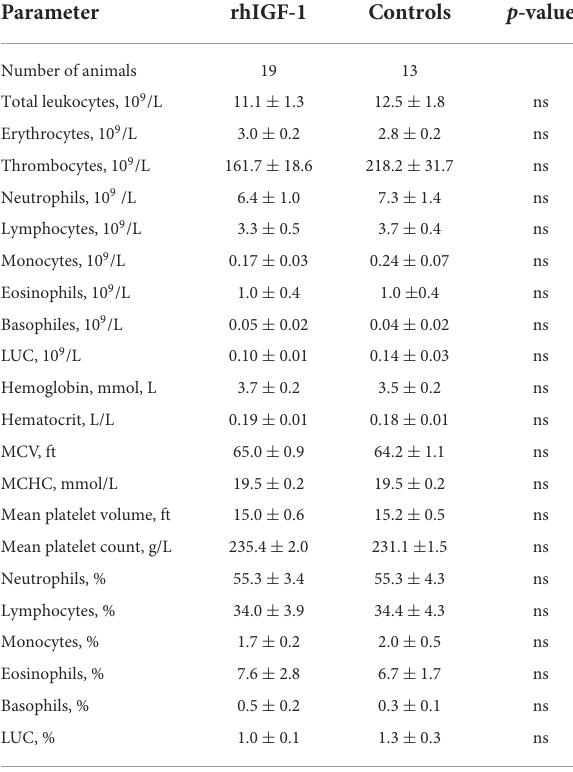
TABLE 3 Hematology of preterm pigs treated with rhIGF-1 or vehicle formulation subcutaneously for 8 days in Experiment 1. Parameter rhIGF-1